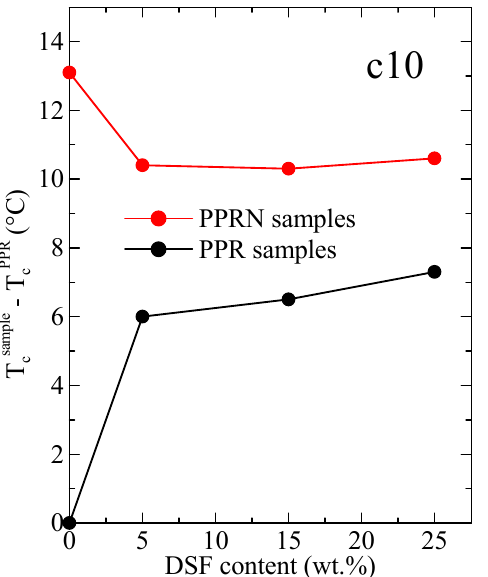
Figure 8. Variations with the DSF content in the differences between the peak crystallization temperature of a certain sample and that of the PPR specimen for the cooling rate of 10 °C/min.